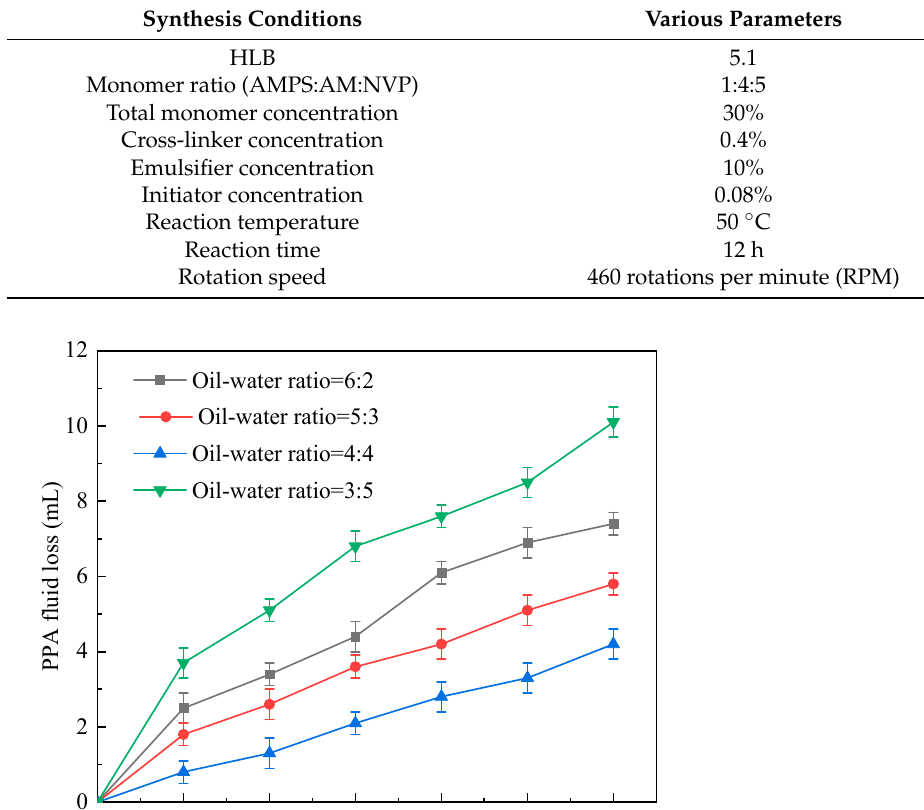
Table 2. The synthesis conditions of AMN other than oil-water ratio.